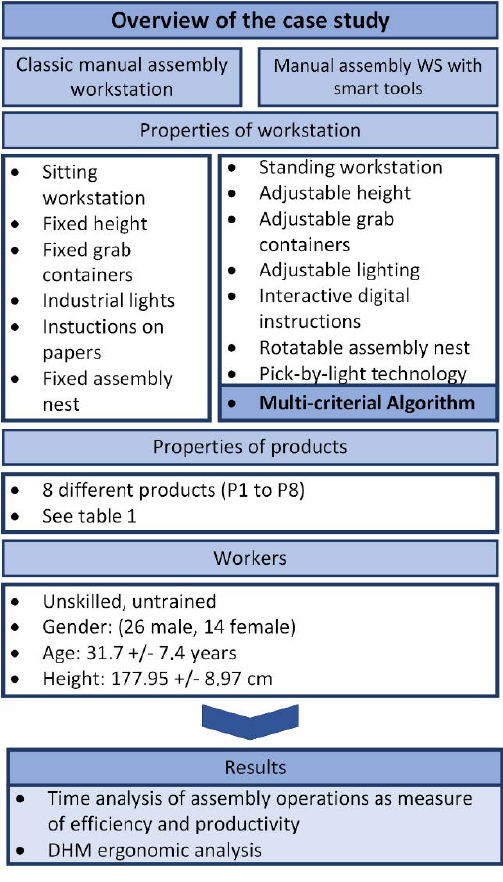
Figure 2. Overview of the case study.